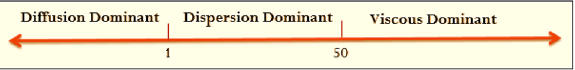
Fig. 4 Flow regimes according to Pe´clet number